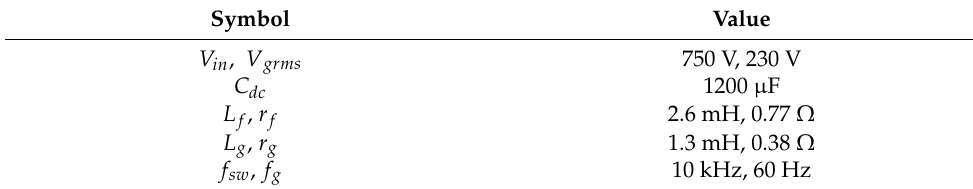
Figure 6. Typhoon HIL testbed. Table 1. System